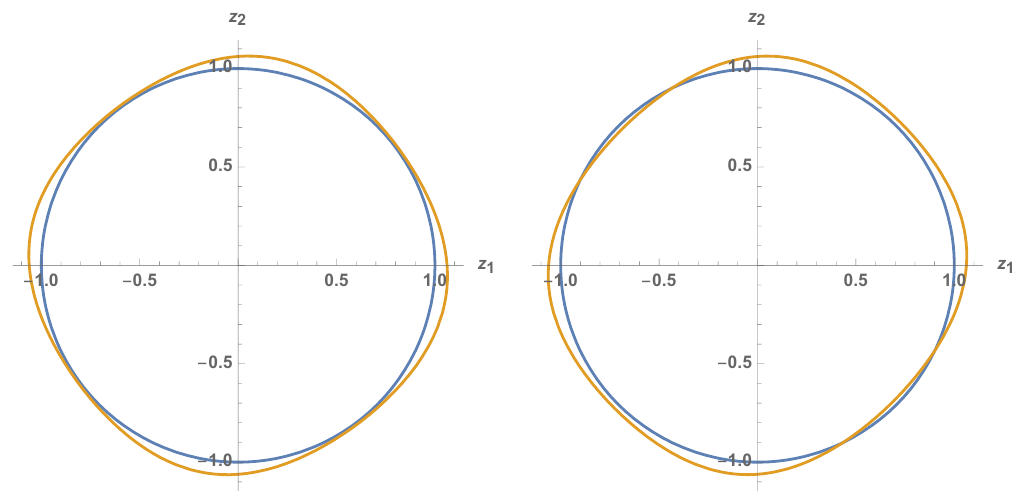
Figure 2 . Left: the corrections to the extremality curve are everywhere positive, hence the WGC is satis(cid:12)ed. (Right): the corrections to the extremality curve are not everywhere positive; large extremal black holes cannot always decay to intermediate mass black holes, whether or not the WGC is satis(cid:12)ed cannot be decided in the low-energy